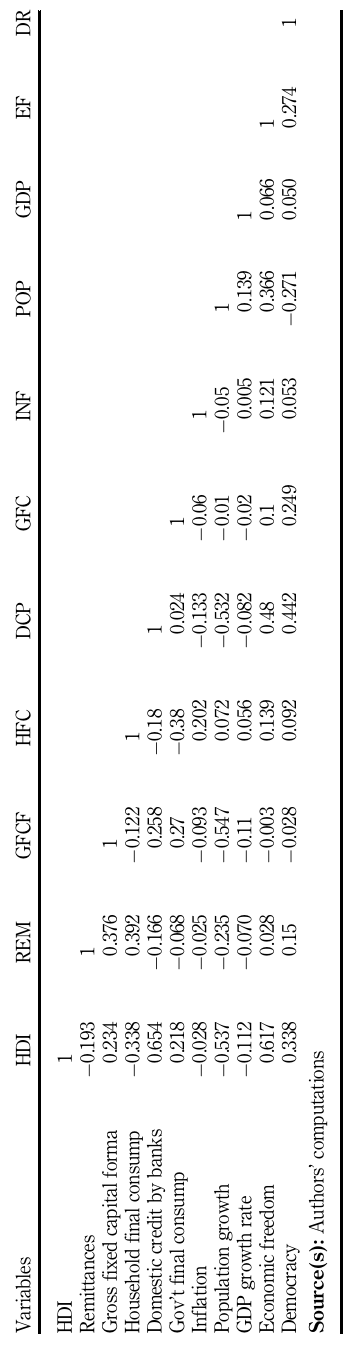
Table 3. Correlation